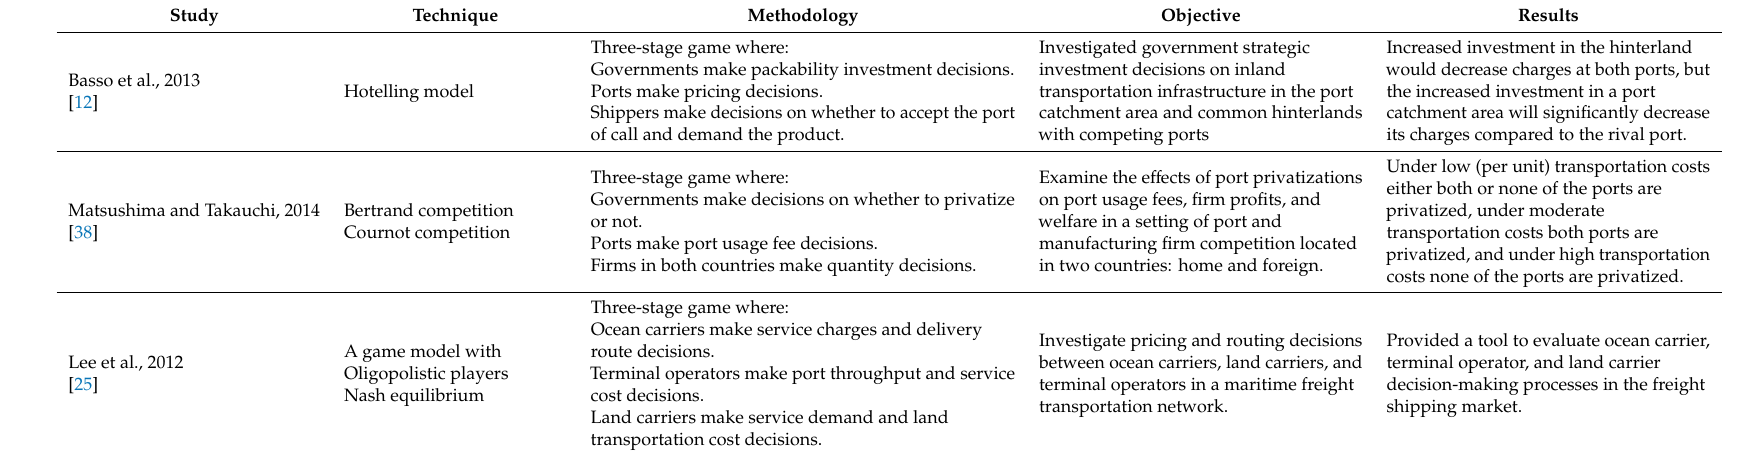
Table 5. Summary of Other Types of Maritime Transportation Cooperation and